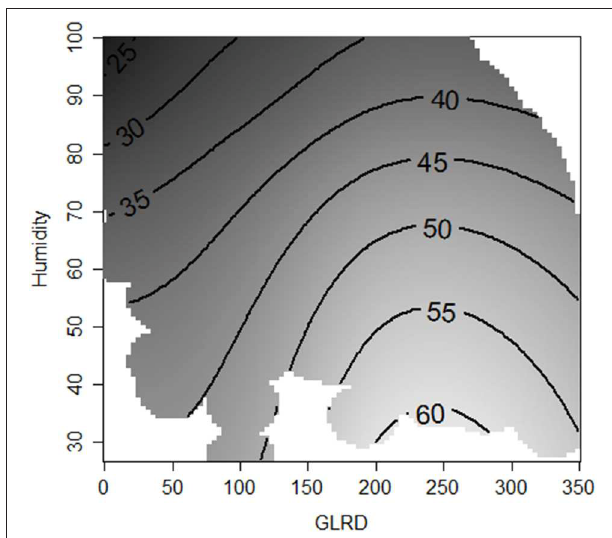
FIGURE 10 | Effect of interactions of GLRD*relative humidity upon expected ambient O 3 concentration, BKR